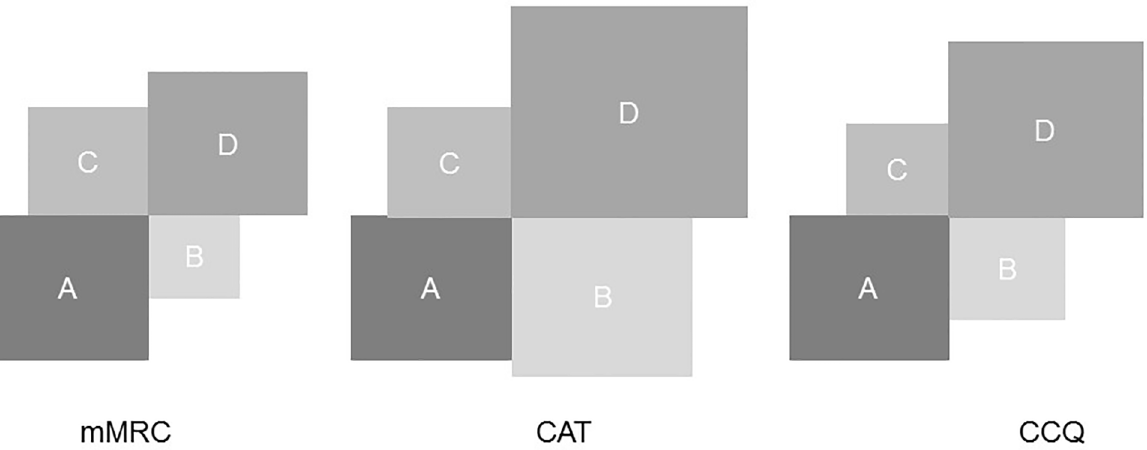
Fig 4. Patient distribution across the different GOLD classifications. The size of the squares represent the patient distribution relative to quadrant A. mMRC = combined assessment using mMRC; CAT = combined assessment using CAT; CCQ = combined assessment using CCQ.